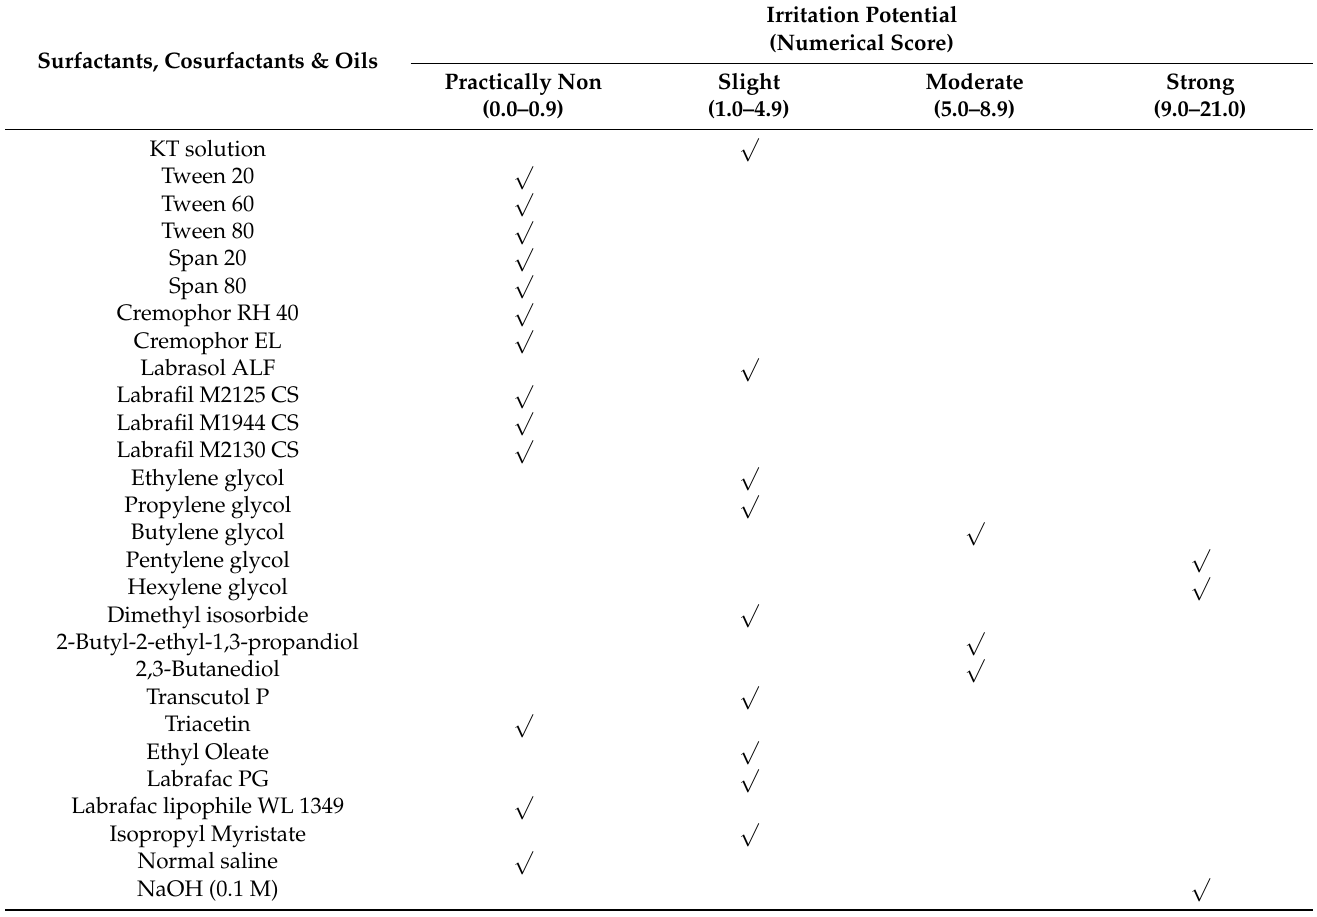
Table 6. Ocular irritation potential calculated from the cumulative scores of the vascular responses of the CAM.